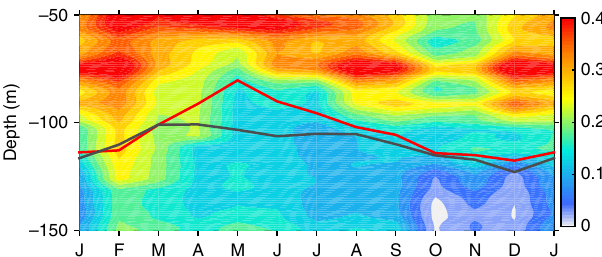
Figure 6 | Monthly occurrence frequency of low Richardson number. The occurrence frequency is calculated as the ratio of numbers of Ri r 0.35 over numbers of all Ri in 10-m bins. The red curve denotes the average depth of EUC core and the black curve denotes the average depth of the thermocline